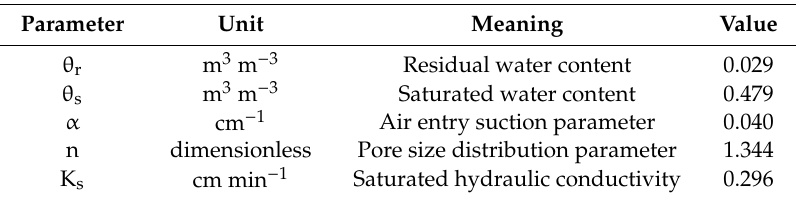
Table 1. Parameters of the engineered soil’s water retention curve and saturated hydraulic conductivity as used in HYDRUS-2D.